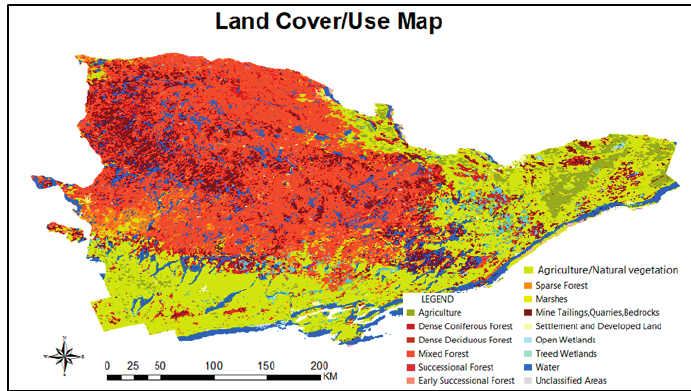
Figure 3. The land use/cover map of this study generated from 30-m TM imagery.